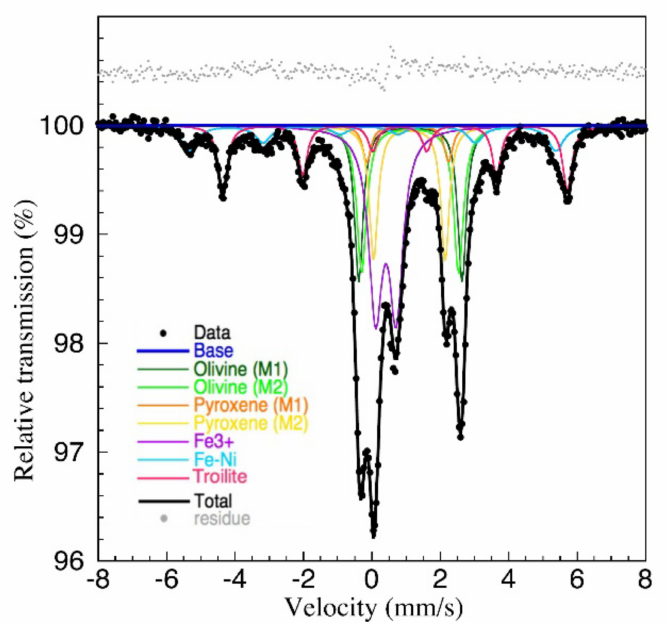
Figure 21. Room temperature Mössbauer spectrum of ordinary chondrite Y-790272 H4. Indicated components are the results of the fits. The residual (differential spectrum) is shown on the top. Adapted from Reference